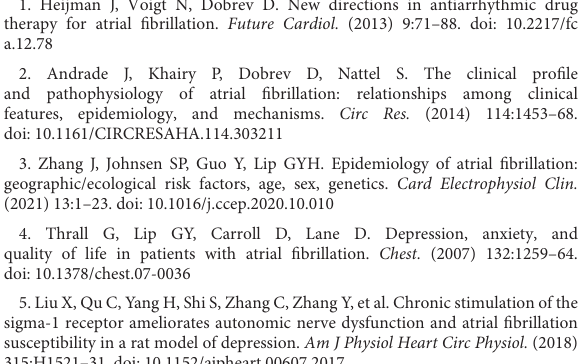
SUPPLEMENTARYFIGURES3 The adrenergic β 1 receptor and M2 ACh receptor expression on the cell plasma membrane by Western blot. (A) Adrenergic β 1 receptor and (B) muscarinic acetylcholine M2 receptor expression on the plasma membrane with Western blot in sham and pain groups. The results are expressed as mean ± standard deviation. The histograms represent values. ∗ represents p < 0.05 (two-tailed Student’s t -tests). SUPPLEMENTARYFIGURES4 The RGS4 protein expression by Western blot in sham and pain groups. The results are expressed as mean ± standard deviation. The histograms represent values. ∗∗ represents p < 0.005 (two-tailed Student’s t